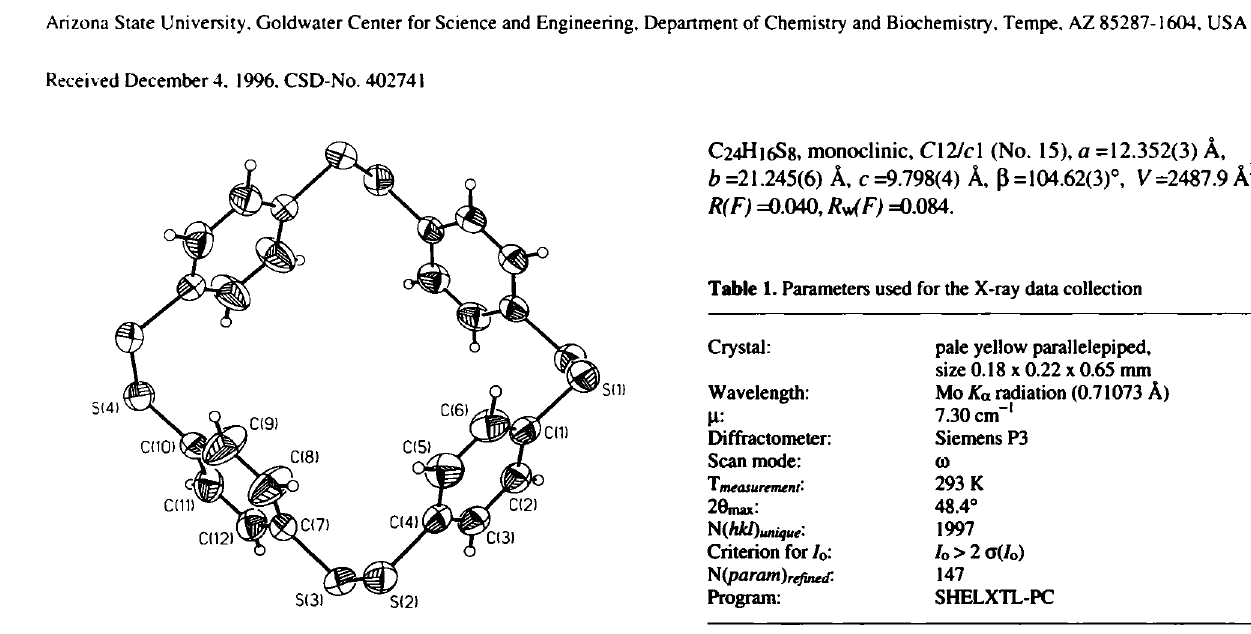
Table 2. Final atomic coordinates and displacement parameters (in Â 2